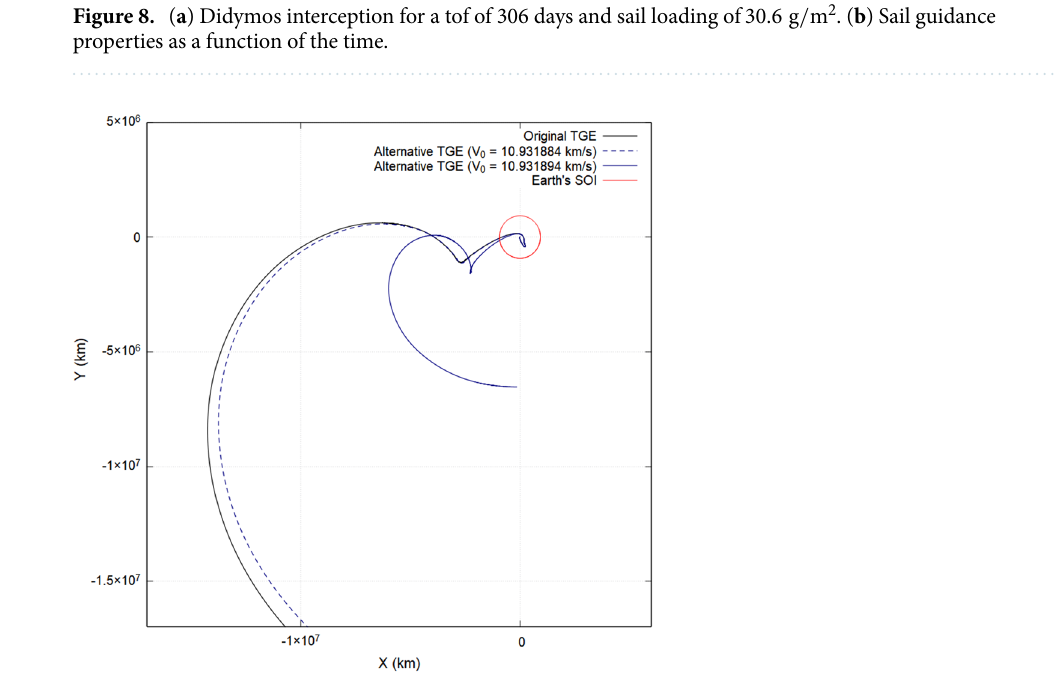
Figure 9. Trajectory of the proposed TGE and some of its possible